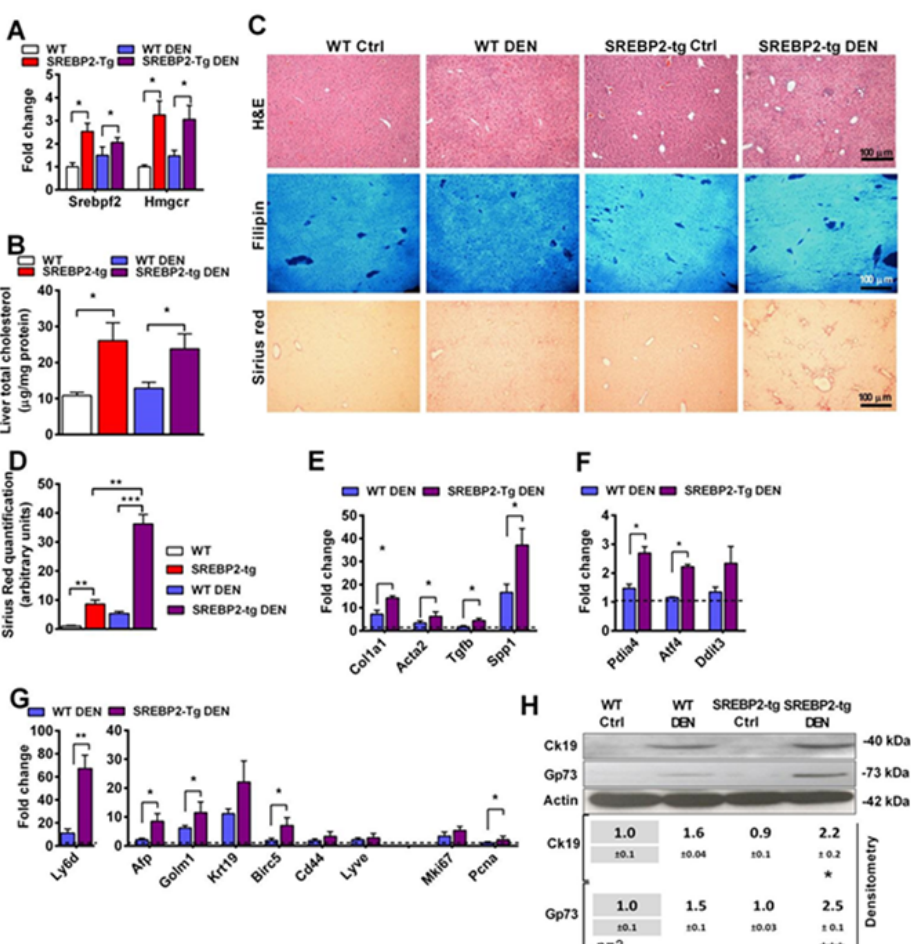
Figure 3. Treatment of wild-type (WT) or transgenic SREBP-2 mice (SREBP2-tg) with DEN in the drinking water for 24 weeks, compared to their respective non-DEN-treated animals (Ctrl). ( A ) Srebpf2 and its target gene Hmgcr mRNA levels in the livers of SREBP2-tg animals, determined by qPCR. ( B ) Total cholesterol levels in the liver tissues in the different groups of animals. ( C ) Representative histological staining of liver sections for hematoxylin–eosin (H&E), free cholesterol (filipin), and fibrosis (Sirius red staining). ( D ) Sirius red quantification from the stained liver sections. ( E ) Determination by qPCR of the fibrosis-related genes ( Col1a1 , Acta2 , Tgf β , and Spp1 ) of the animals treated with DEN from both genotypes. The values are relative to the WT control. ( F ) Determination by qPCR of ER stress markers Pdia4 , Atf4 , and Ddit3 . ( G ) The expression of the stem cells, proliferation, and HCC-associated markers in WT and SREBP2-tg animals treated with DEN. ( H ) Immunoblotting of Ck19 and Gp73 proteins in the liver of WT and SREBP-2 tg mice and a densitometry analysis of the blots relative to the WT Ctrl group, displaying the significance when compared to their corresponding WT or WT DEN control. Uncropped films from immunoblots in Figure S4. Values in the qPCR determinations are relative to the WT control treatment (1.0 value depicted as a dotted line); only DEN-treated groups are displayed ( N = 4 to 5 per group). All values are the mean ± SEM. *, **, and *** represent the statistically significant differences ( p < 0.05, p < 0.01, or p < 0.001, respectively) in the ANOVA and Bonferroni’s post-test compared to the indicated